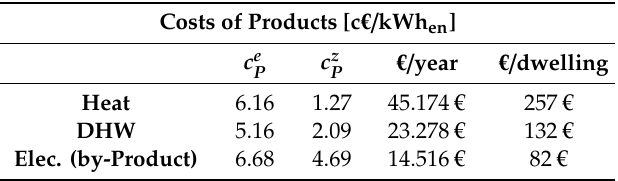
Table 5. Unit costs of system products and annual total costs.